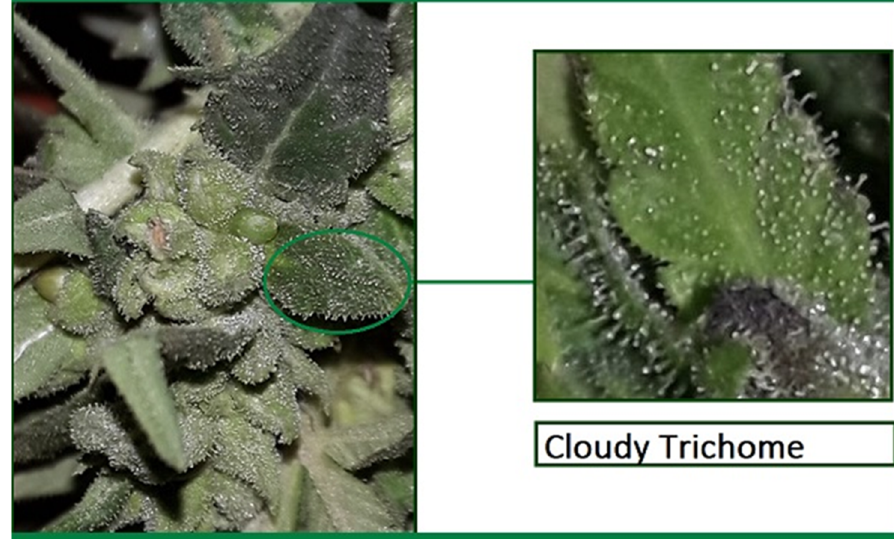
Figure 2. Morphological appearance of white or milky trichome of medicinal Cannabis.